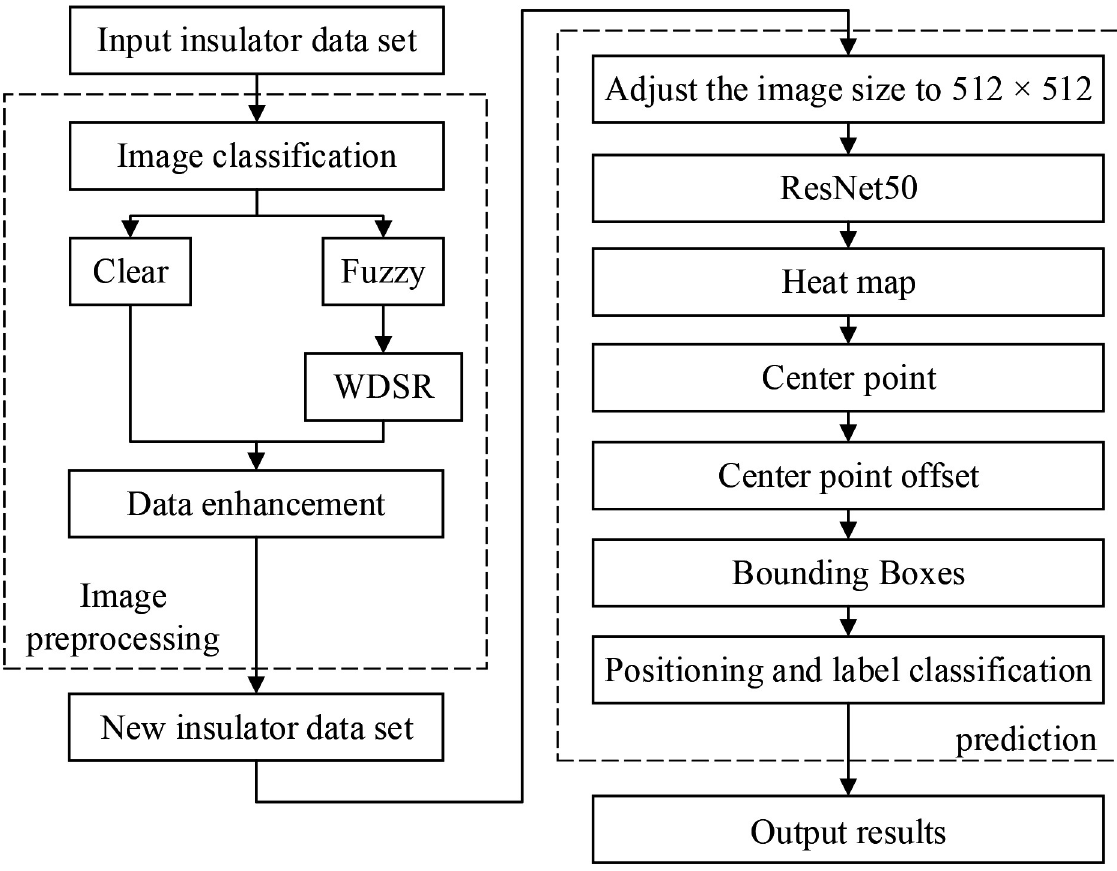
Fig 1. Flow chart of defect insulator